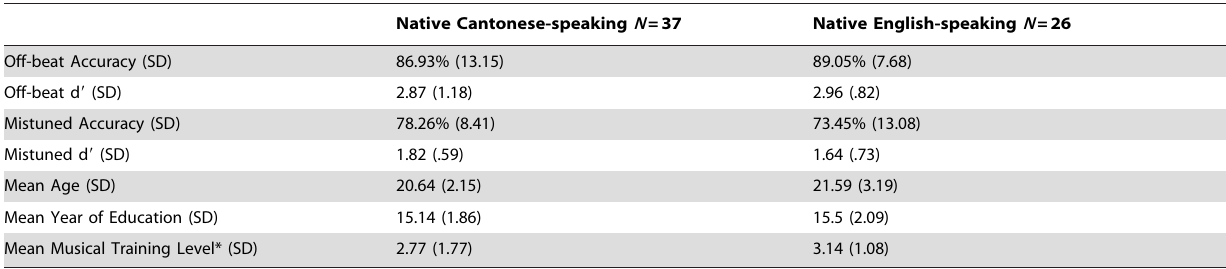
Table 4. Demographic information and results for participants from Experiment